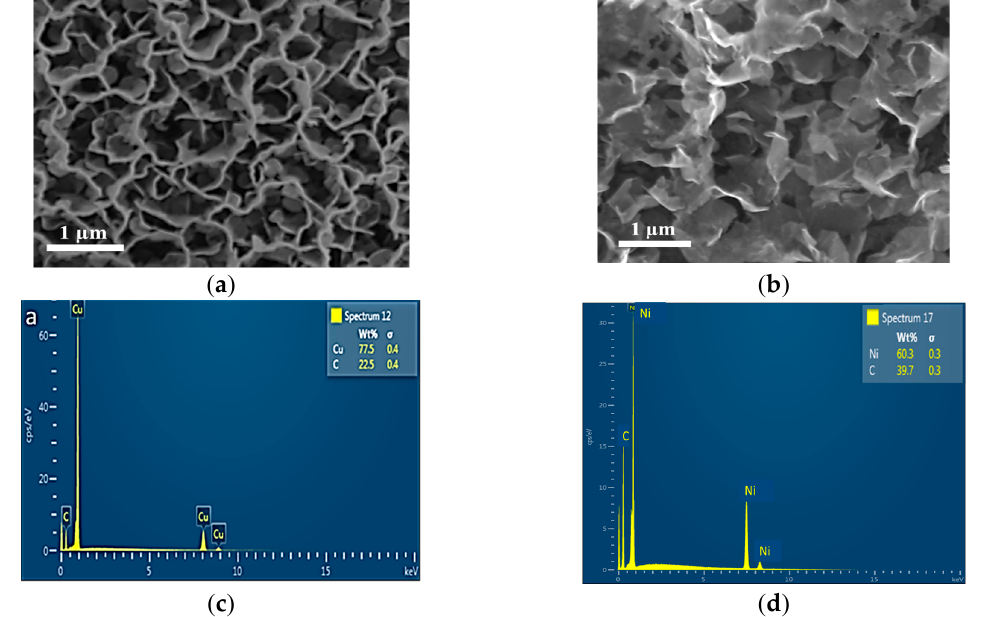
Figure 2. ( a , b ). Representative SEM images of graphene nanowalls produced from ( a ) methane on copper substrate and ( b ) from bagasse on nickel substrate . ( c , d ) EDS spectra of graphene formed from ( c ) methane on copper substrate and ( d ) from bagasse on nickel substrate .